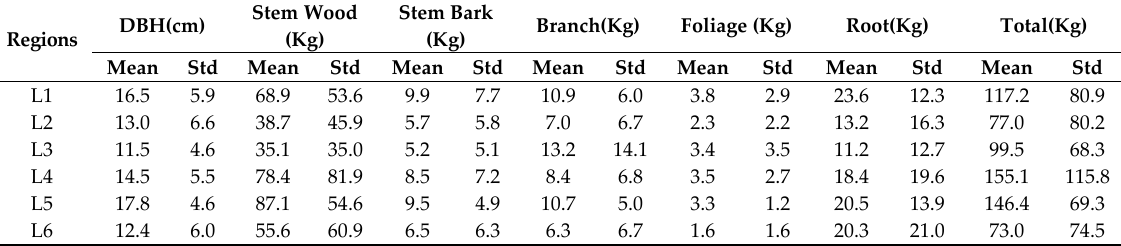
Table 2. Descriptive statistics of trees sampled for fitting the biomass equations (Std, standard